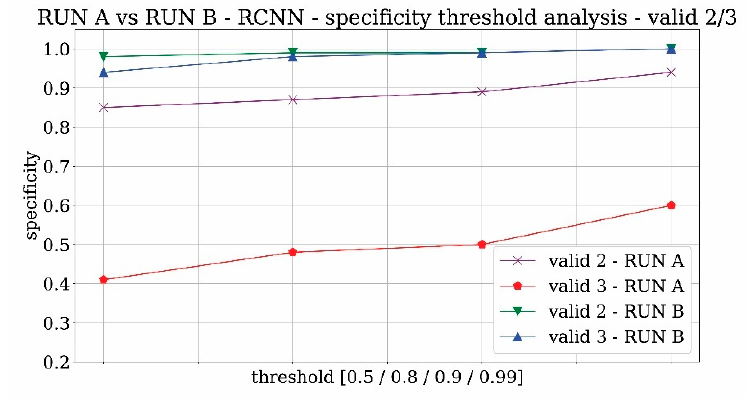
Figure 12. Sensitivity threshold analysis for RUN A and RUN B with valid 1 and 4.